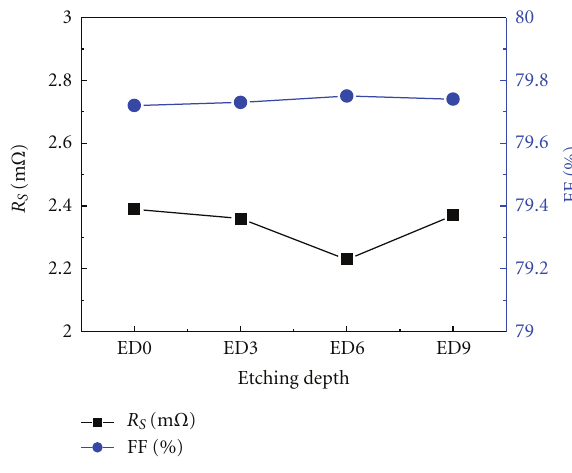
Figure 7: V OC and I SC of four di ff erent etching depths.